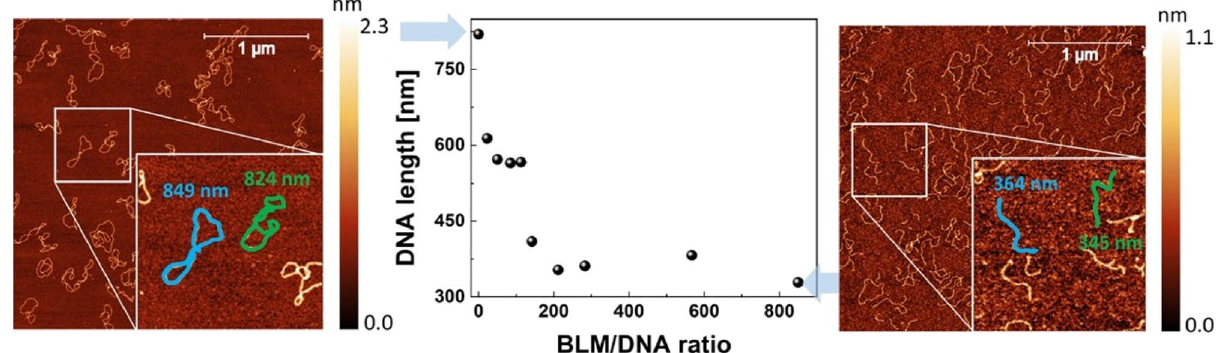
Figure 2. Average length of DNA fragments [nm] versus BLM/DNA molar ratio (statistical details and typical AFM images of DNA treated with various concentrations of BLM are presented in Supplementary Table S1 and Supplementary Fig. S1 respectively). AFM images of the pUC19 DNA plasmid deposited on mica indicating untreated (control) DNA (left) and DNA treated with an 850 BLM/DNA molar ratio (right). In the magnified area of AFM topographies, the concept of DNA molecule length tracing is schematically